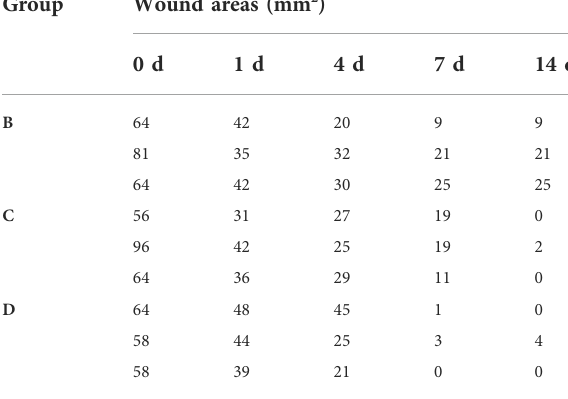
TABLE 2 Wound areas of mice in each group.